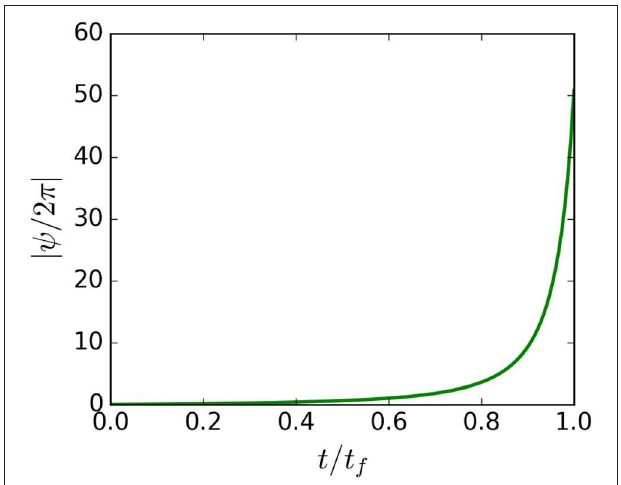
FIGURE 9 | RMS shift in particle gyro orbits against time of flight.